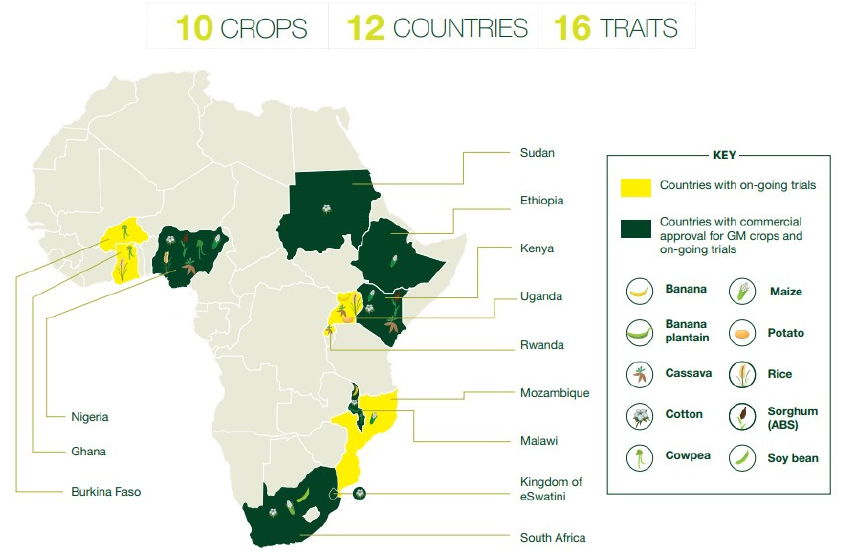
Figure 1. GM crop adoption in Sub-Saharan Africa, 2020. Source: ISAAA AfriCenter, 2021.